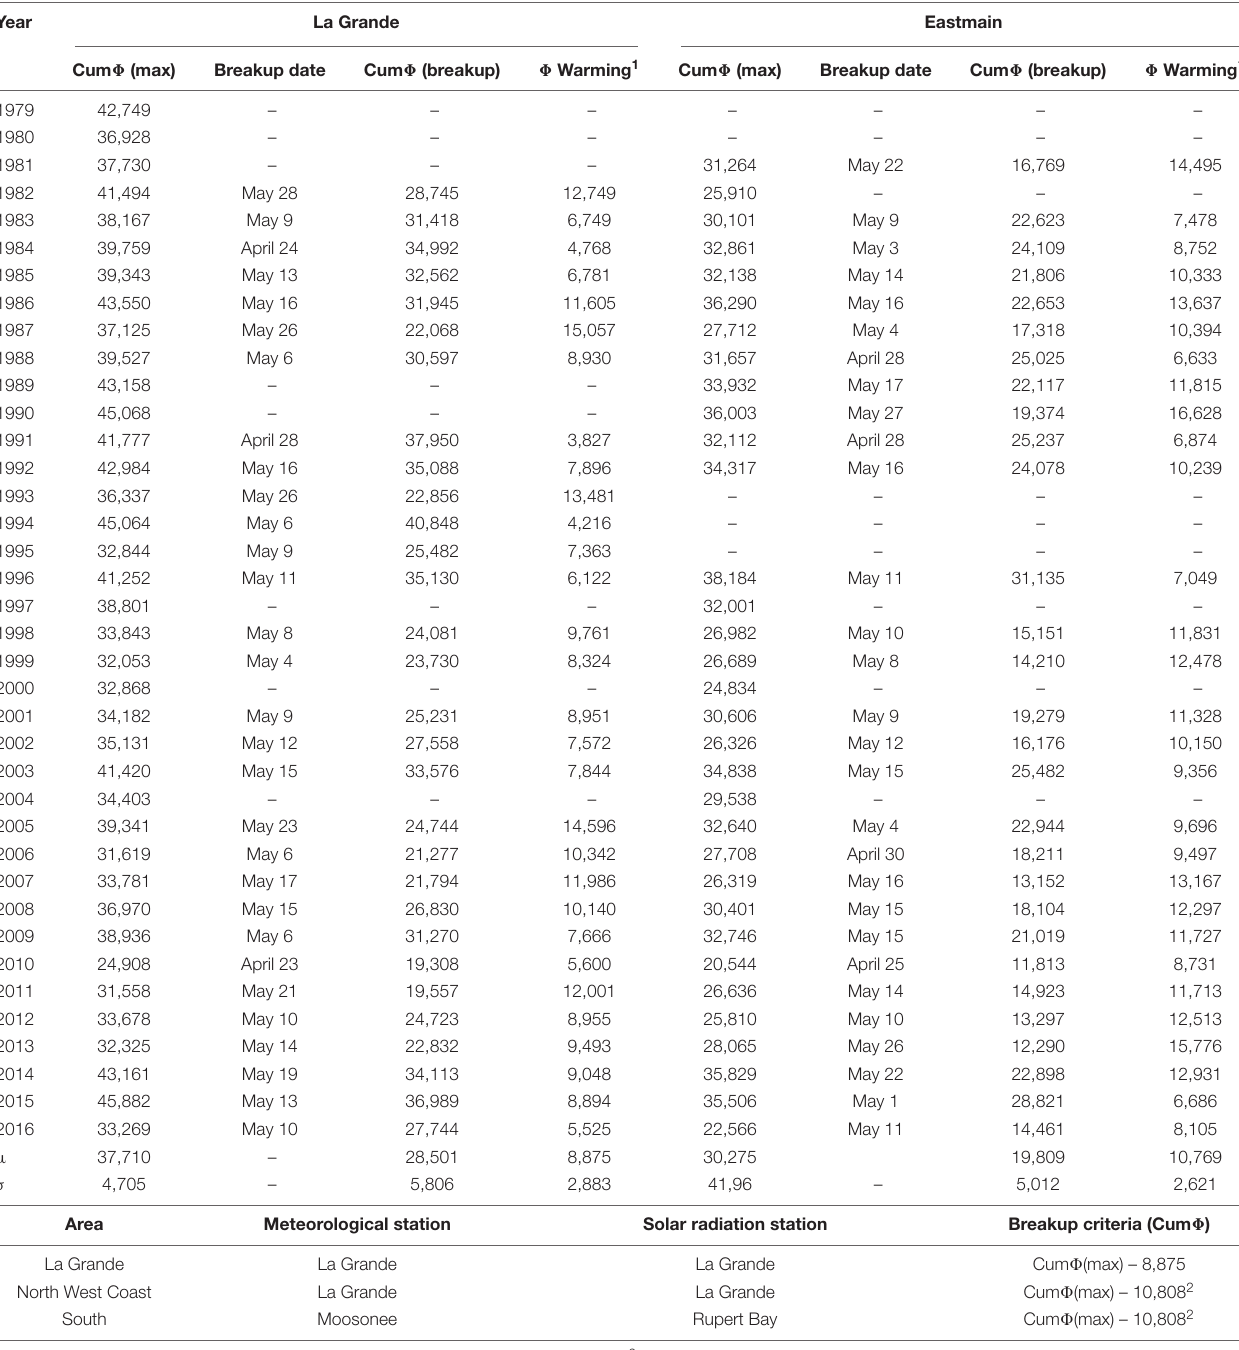
TABLE 2 | Breakup criteria in James